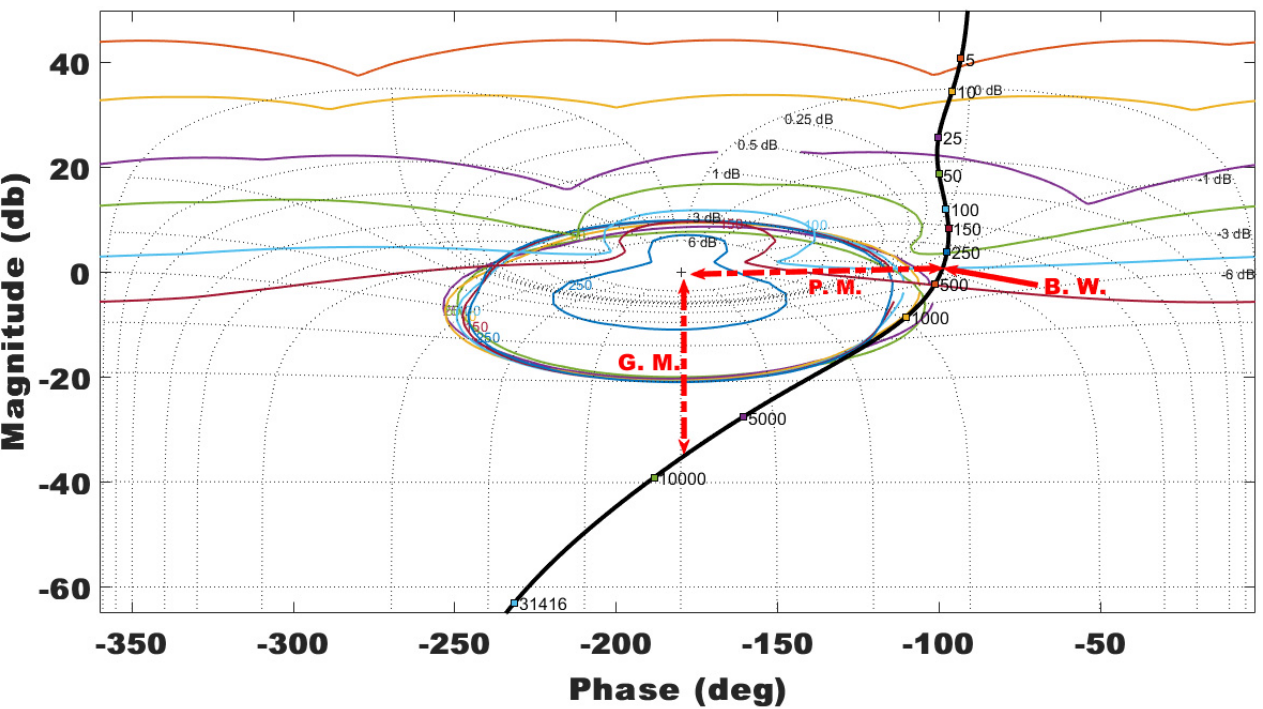
Figure 8. Automated loop-shaping QFT using FPA optimization.